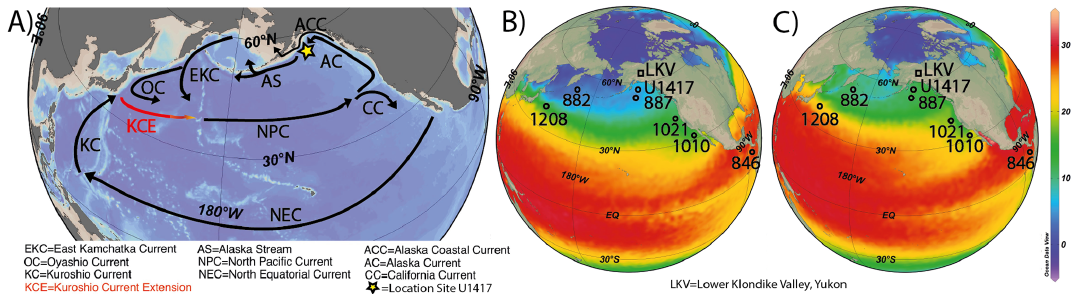
Figure 1. Map of modern ocean circulation and SSTs. (a) Modern North Pacific Ocean circulation, (b) December and (c) September 1955– 2013 SST average centred in the North Pacific Ocean (NOAA WOA13; Locarnini et al., 2013), and core and sample sites discussed in this study. Map made using Ocean Data View (Schlitzer,